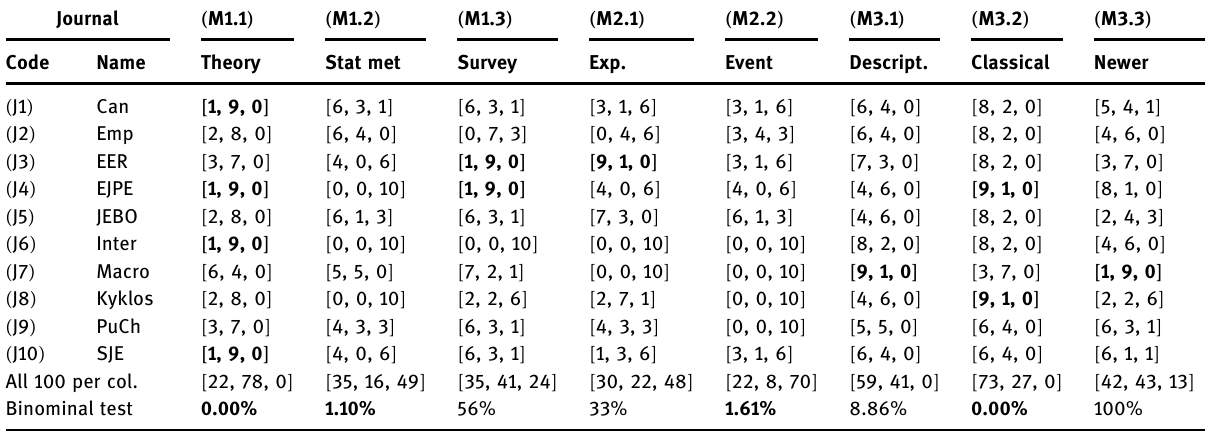
Table 6: Trend - scores and tests for the eight subgroups of methods across the 10 journals